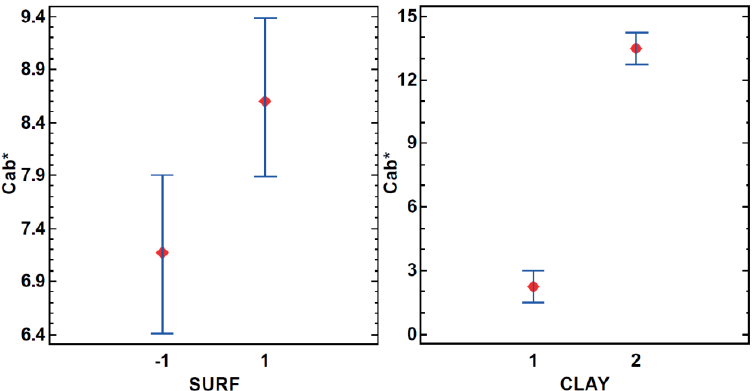
Figure 9. Graphic CIELAB plots for laponite (LAP), halloysite (HA) and the hybrid pigments with chlorophyll, GLAP and GHA using the D65 illuminant and the CIE-1931 XYZ standard observer. Left: CIE-a* b* color diagram; right: CIE-Cab* L* color chart.